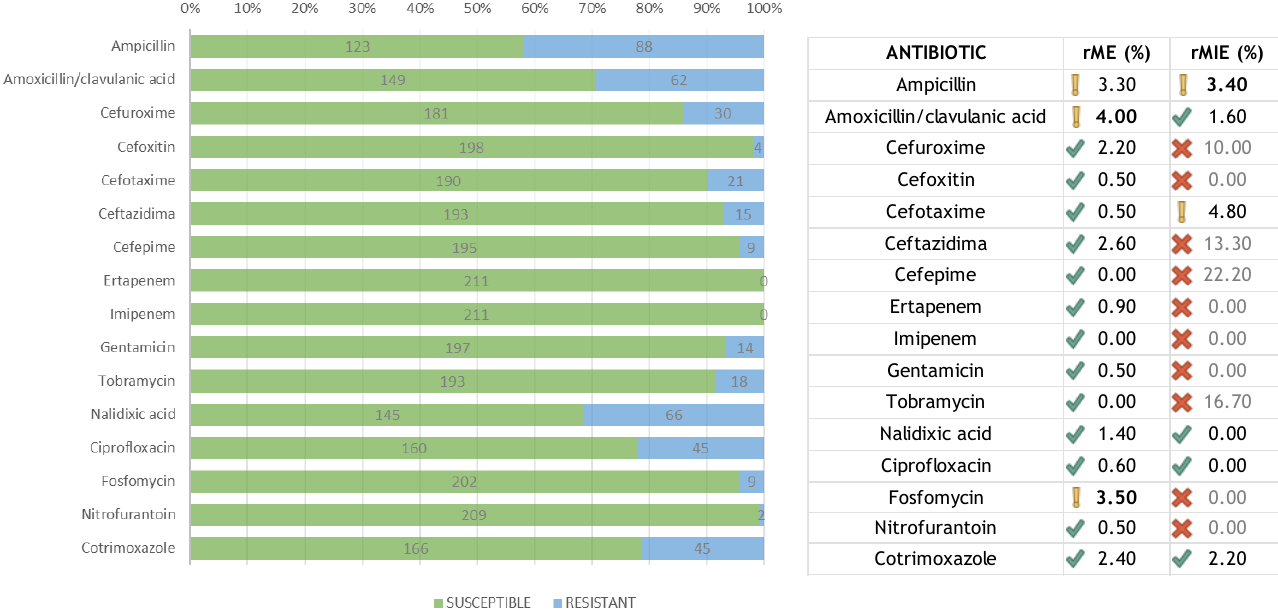
Figure 1. Number of susceptible and resistant isolates for each antibiotic, and their re-calculated errors.